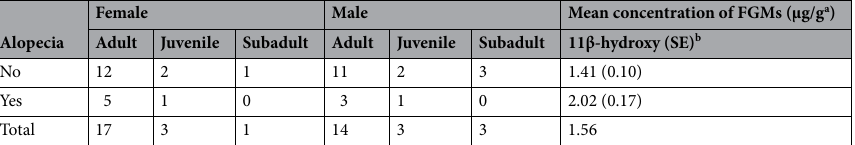
Table 4. Individual characteristics of fecal samples of Formosan macaques with and without alopecia in Mt. Longevity and the results of FGM concentration through EIA analysis. a Dry weight of fecal sample. b Mean and standard error of 11β-hydroxyetiocholanolone.